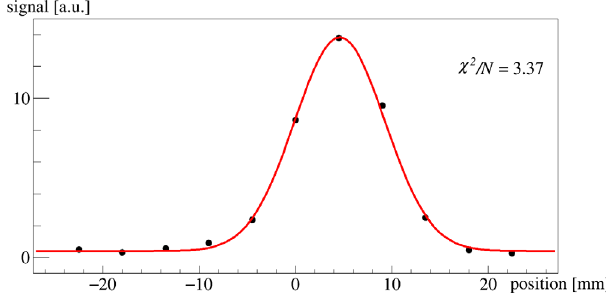
FIG. 5. Example of integrated signals of Inj-MRPM. The black points represent the integrated signals of Inj-MRPM and the red line represents the fitting. This is the data at the turn 10 of the beam and corresponding to the condition ð ν x ; ν y Þ ¼ ð 21 . 08 ; 21 . 43 Þ